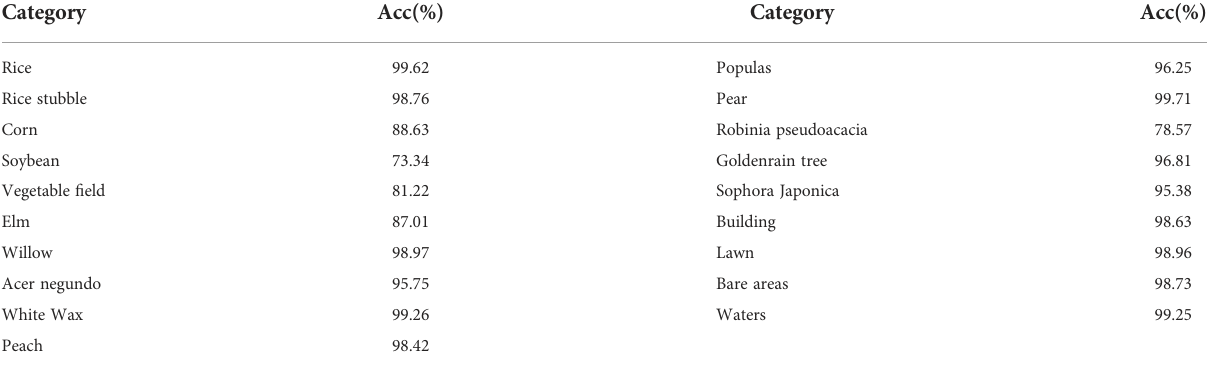
TABLE 4 Overall classi fi cation accuracy assessment of different categories based on improved U-Net model.